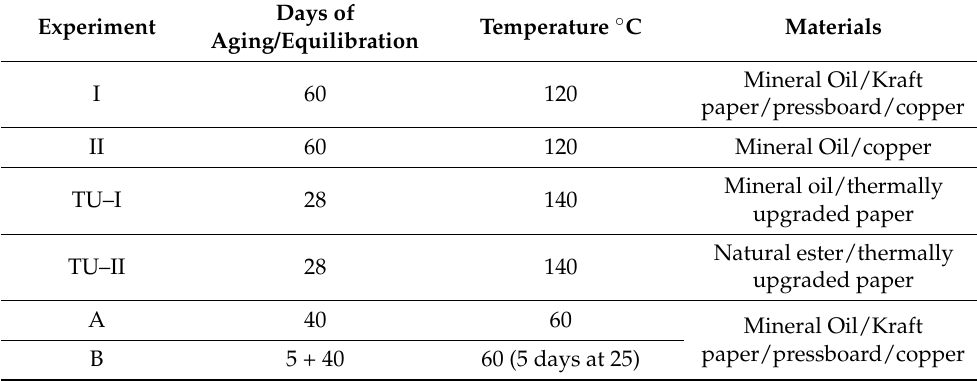
Table 4. Experiments